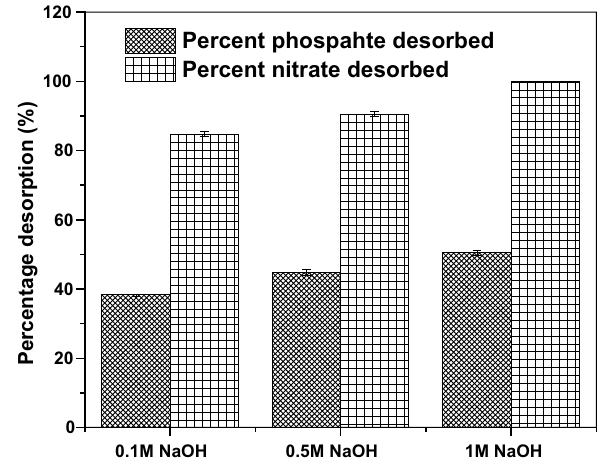
Fig. 7 Simultaneous desorption of phosphate and nitrate using NaOH